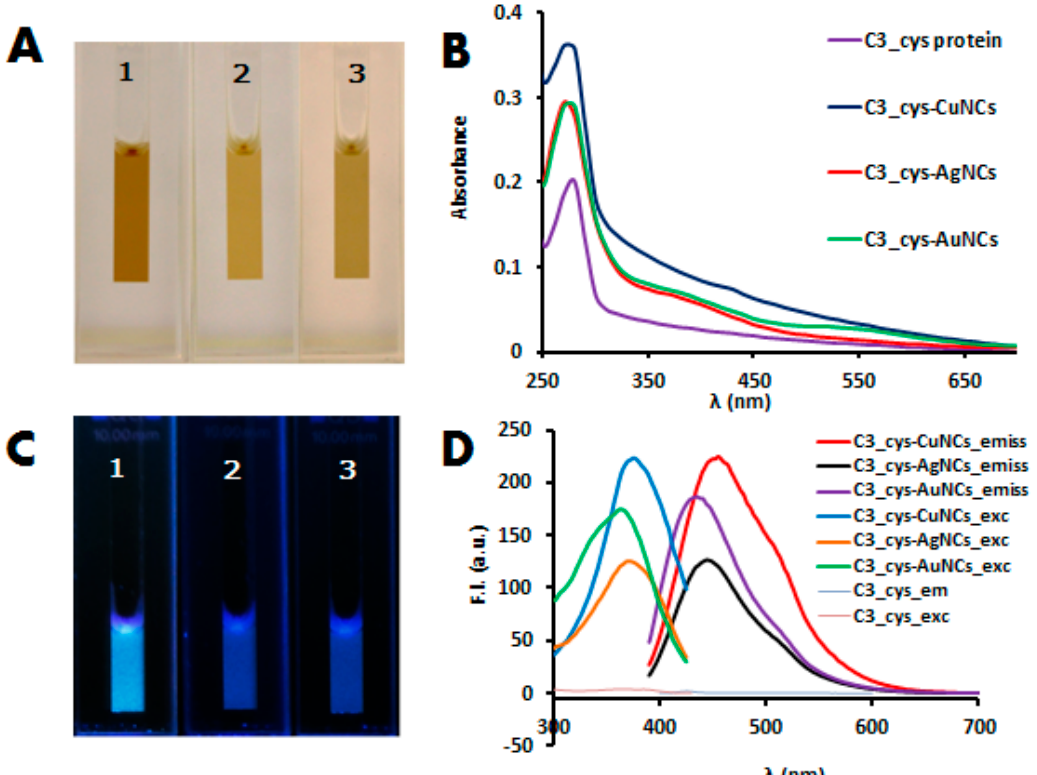
Figure 1. ( A , C ) images of consensus tetratricopeptide repeat (CTPR)-metal nanoclusters (NCs) solution under visible light and UV light: C3_cys-CuNCs (1), C3_cys-AgNCs (2), and C3_cys-AuNCs (3). ( B ) Absorption spectra of the non-conjugated CTPR protein and the synthetized protein-NCs conjugates. ( D ) Excitation and emission spectra of CTPR control protein without NCs and CTPR templated NCs.